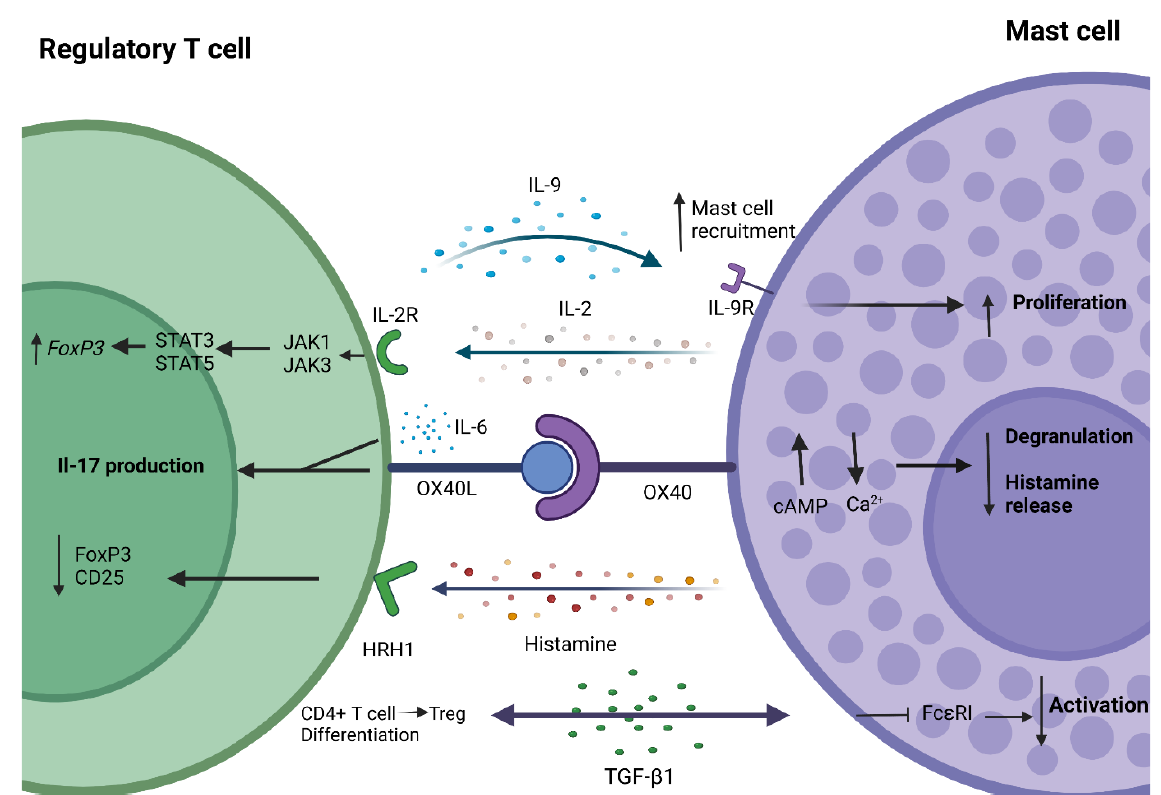
Figure 2. Molecular interactions between Regulatory T Cells (Tregs) and Mast Cells (MCs). Tregs can produce IL-9 to promote MC recruitment and proliferation via IL-9R engagment. MCs can secrete IL-2 and expand the Treg population via stimulation of IL-2R. This mechanism involves the activation of JAK1 and JAK3, then activating STAT3 and STAT5, which translocate into the nucleus to increase the expression of the FoxP3 gene. The OX40/OX40L signalling pathway has bi-directional effects. OX40 stimulation on MCs increases expression of cAMP and decreases cellular Ca 2+ influx; as a result, FcεRI -dependent MC degranulation is suppressed, which blocks histamine release. On Tregs, OX40L signalling together with IL-6 can skew Tregs into IL-17-producing Th17-like cells. Histamine secreted by MCs binds to Histamine H1 receptor (HRH1) on Tregs and directly downregulates FoxP3 and CD25. TGF- β1 secreted by Tregs can inhibit FcεRI signalling in MCs and prevent their activation. On the other hand, MC-derived TGF- β1 can promote the differentiation of CD4 + T cells into Tregs.